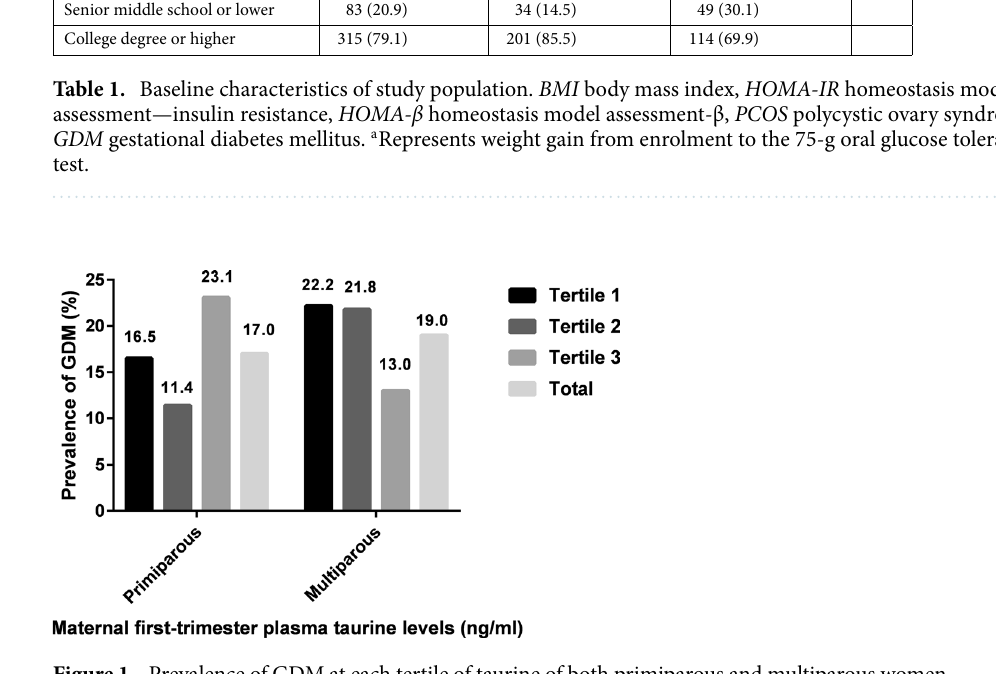
Figure 1. Prevalence of GDM at each tertile of taurine of both primiparous and multiparous